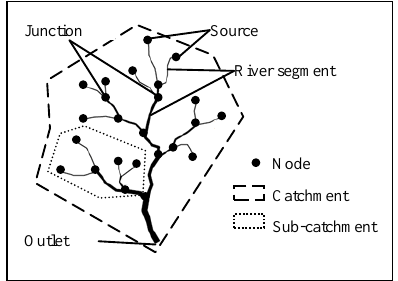
Figure 2. Features in river network (modified from Li, 2007)